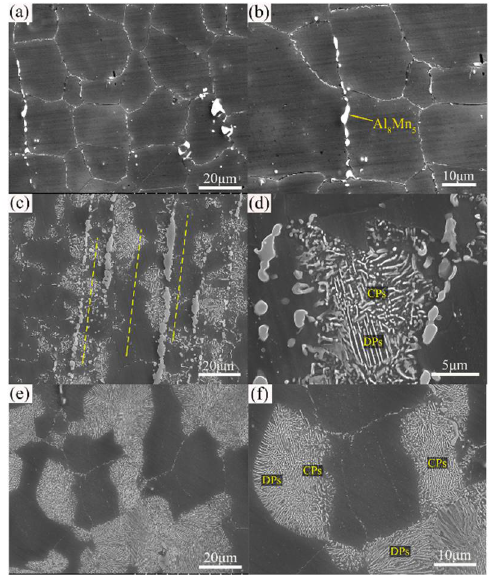
Figure 3. Microstructure of extruded AZ80 Mg alloy after heat treatment ( a , b ) T4, ( c , d ) T5, and ( e , f ) T6. CP, continuous precipitate; DP, discontinuous precipitate [45].